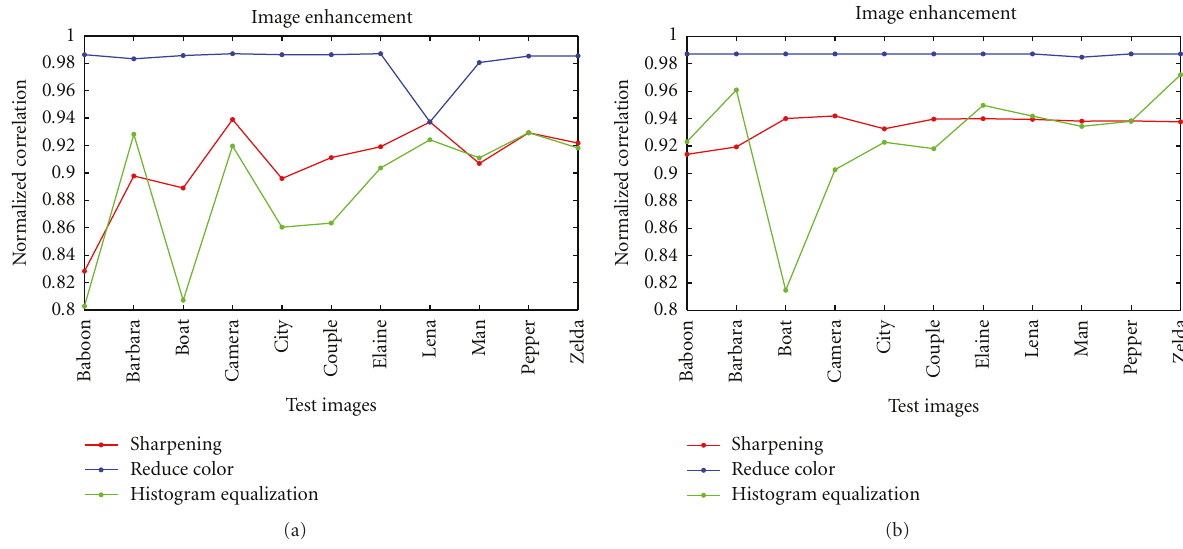
Figure 11: Normalized correlation results of di ff erent test images under image enhancement attacks (a) embedding the watermark in the highest frequency subband of the host image (b) embedding the watermark in the 16th directional subband.